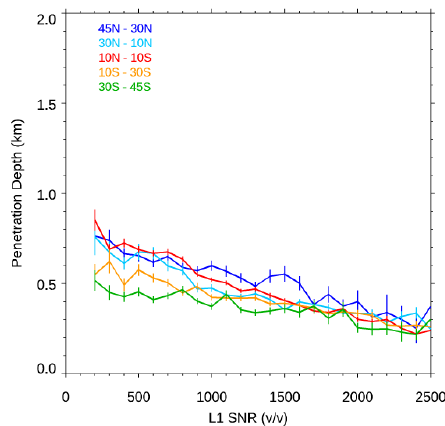
Figure 4. The COSMIC-2 penetration depth over mid-latitude in North Hemisphere (45 ◦ N–30 ◦ N and 30 ◦ N–10 ◦ N) and tropical region (10 ◦ N–10 ◦ S), and mid-latitude Southern Hemisphere (10 ◦ S–30 ◦ S and 30 ◦ S–45 ◦ S) over oceans. We also compute the SEM, which is in a vertical line superimposed to the mean.